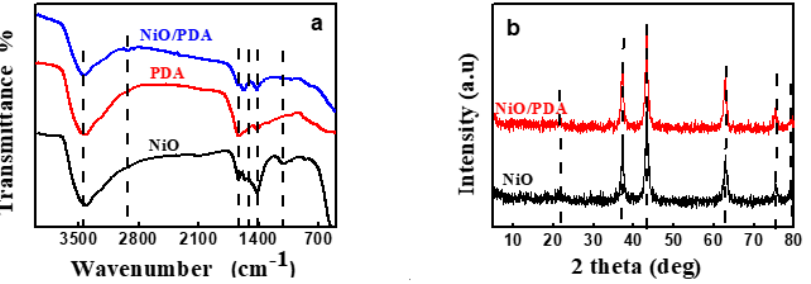
Figure 2. ( a ) FTIR spectra of NiO, PDA, and NiO/PDA, ( b ) XRD patterns of NiO and NiO/PDA. The peak at 1294.35 cm − 1 is attributed to the stretching vibration of CO, while that at 3435.5 cm − 1 can be assigned to the stretched vibration of the OH and NH groups. The relatively large band at the 1500–1100 cm − 1 region, and the band at 1626 cm − 1 , verify the occurrence of the intramolecular cyclization reaction of dopamine along with the